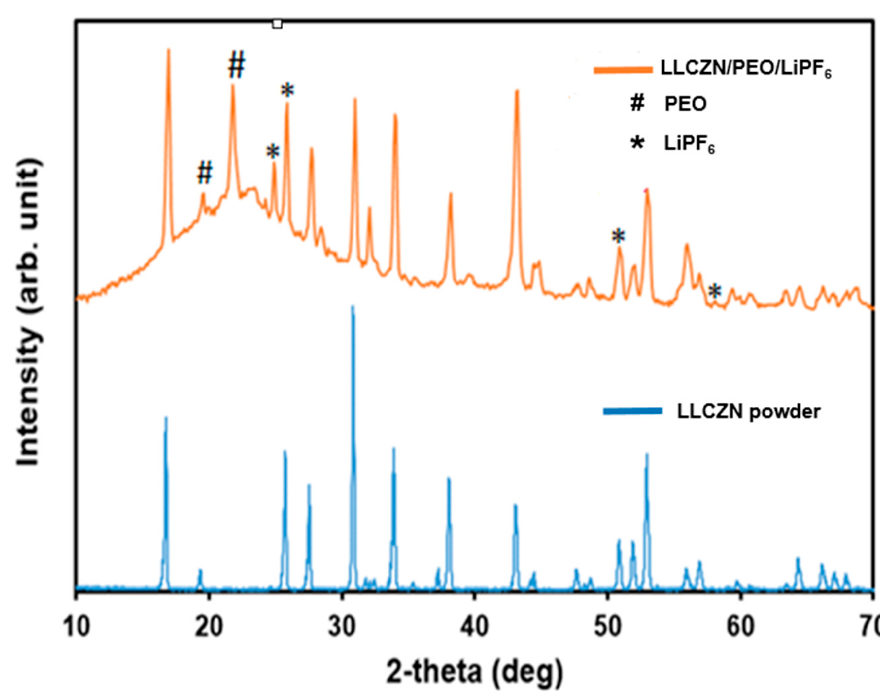
Figure 2. Powder X-ray diffraction patterns of as-prepared LLCZN via sol–gel technique and LLCZN/PEO/LiPF 6 composite powder samples.